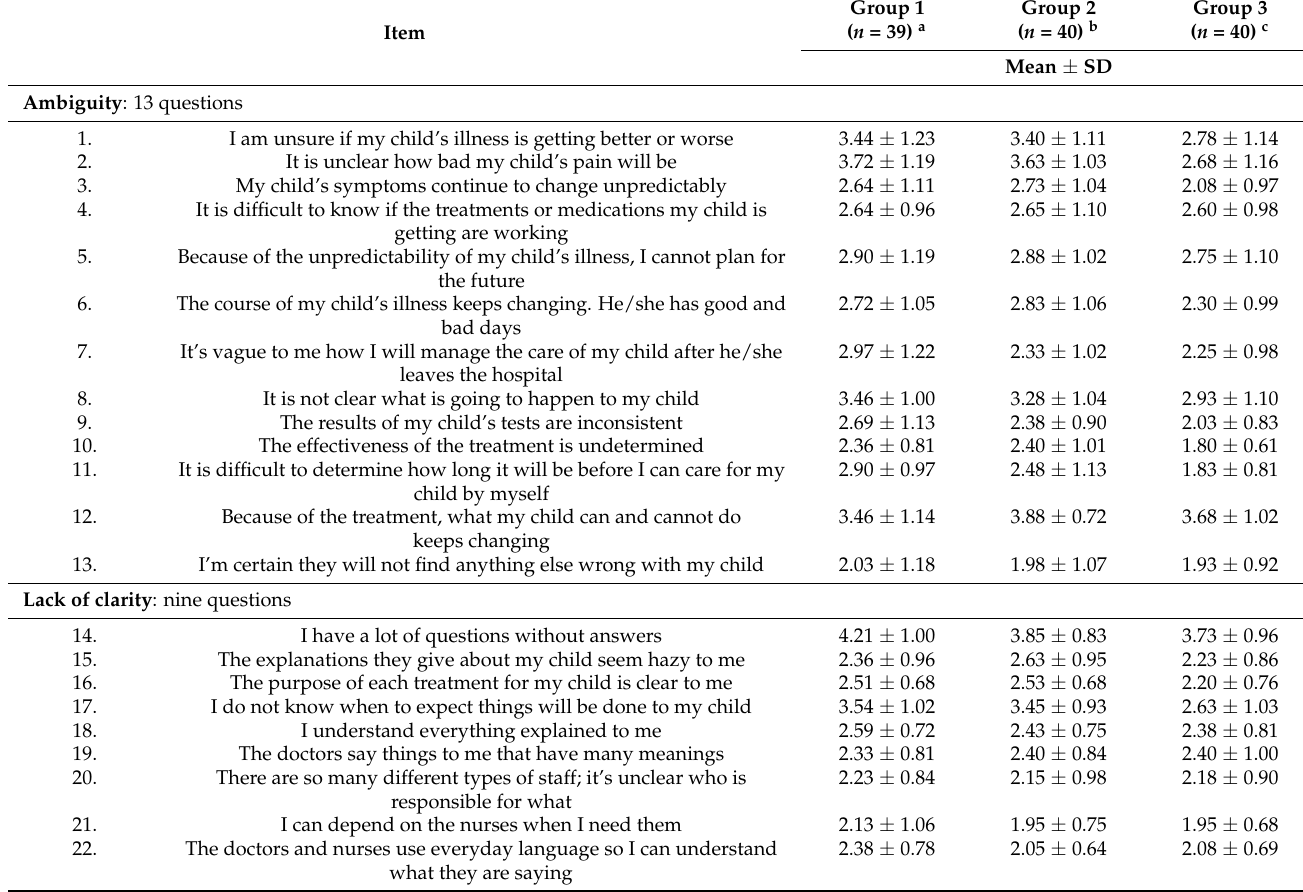
Table 4. Scores for each item on PPKS-FM scale across the treatment phase.